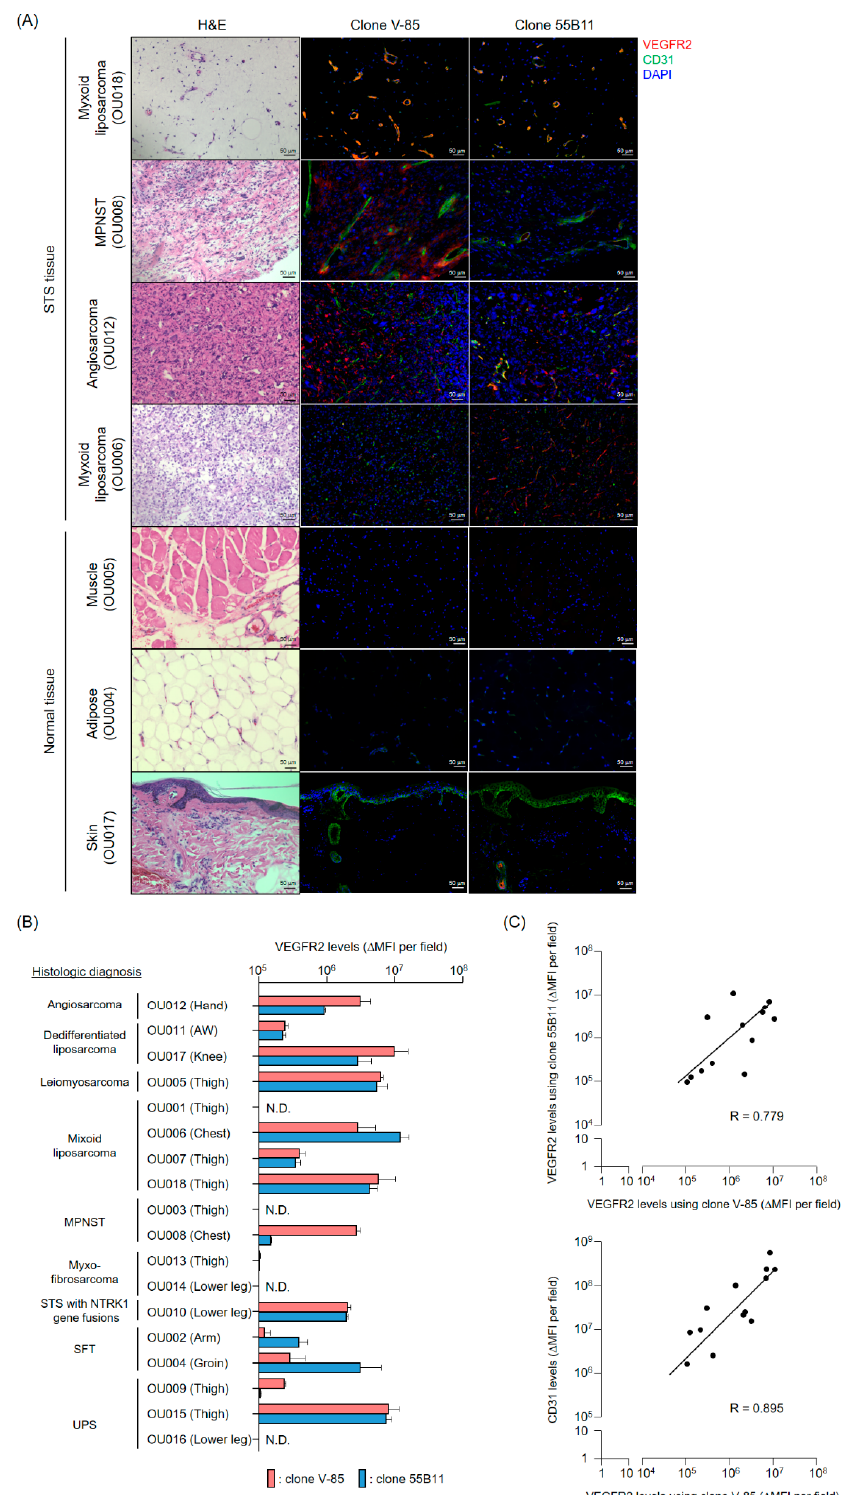
Figure 4. VEGFR2 expression in frozen sarcoma tissues and surrounding normal tissues using immunofluorescence, using the V-85 and 55B11 antibodies. ( A ) Representative images of hematoxylin and eosin (H&E) staining and immunofluorescence staining with anti-VEGFR2 antibody (V-85 or 55B11; red), anti-CD31 antibody (green), and 4 (cid:48) ,6-diamidino-2-phenylindole (DAPI) as a counterstain in serial tissue sections of frozen tumor tissues and surrounding normal tissues from various sarcoma